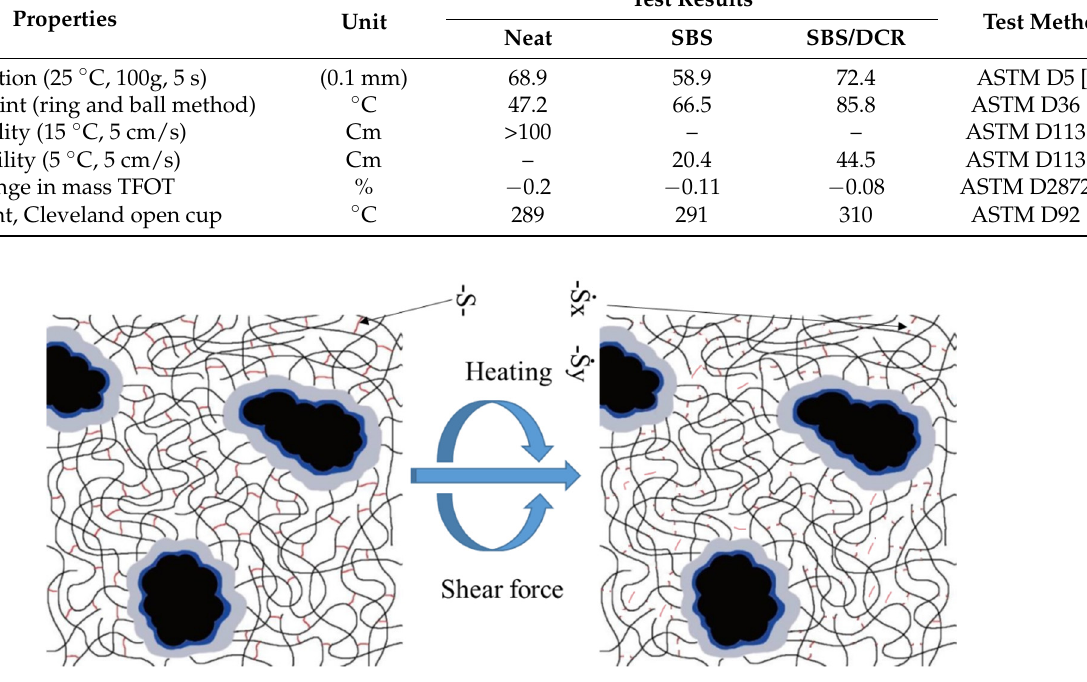
Figure 1. The principle of desulphurization by twin-strew extruder. Table 1. Basic properties of bitumen.